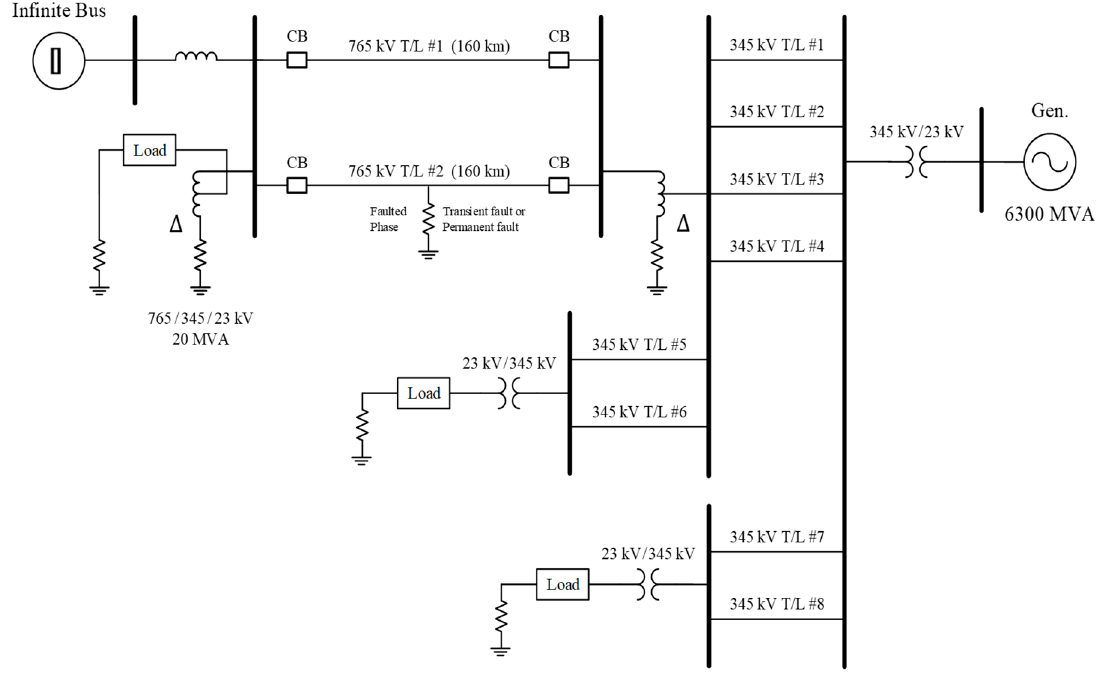
Figure 15. Actual 765 kV transmission system in Korea. Table 5. Simulation results for verification of the ASPAR scheme in a 765 kV transmission line (160 km). Fault